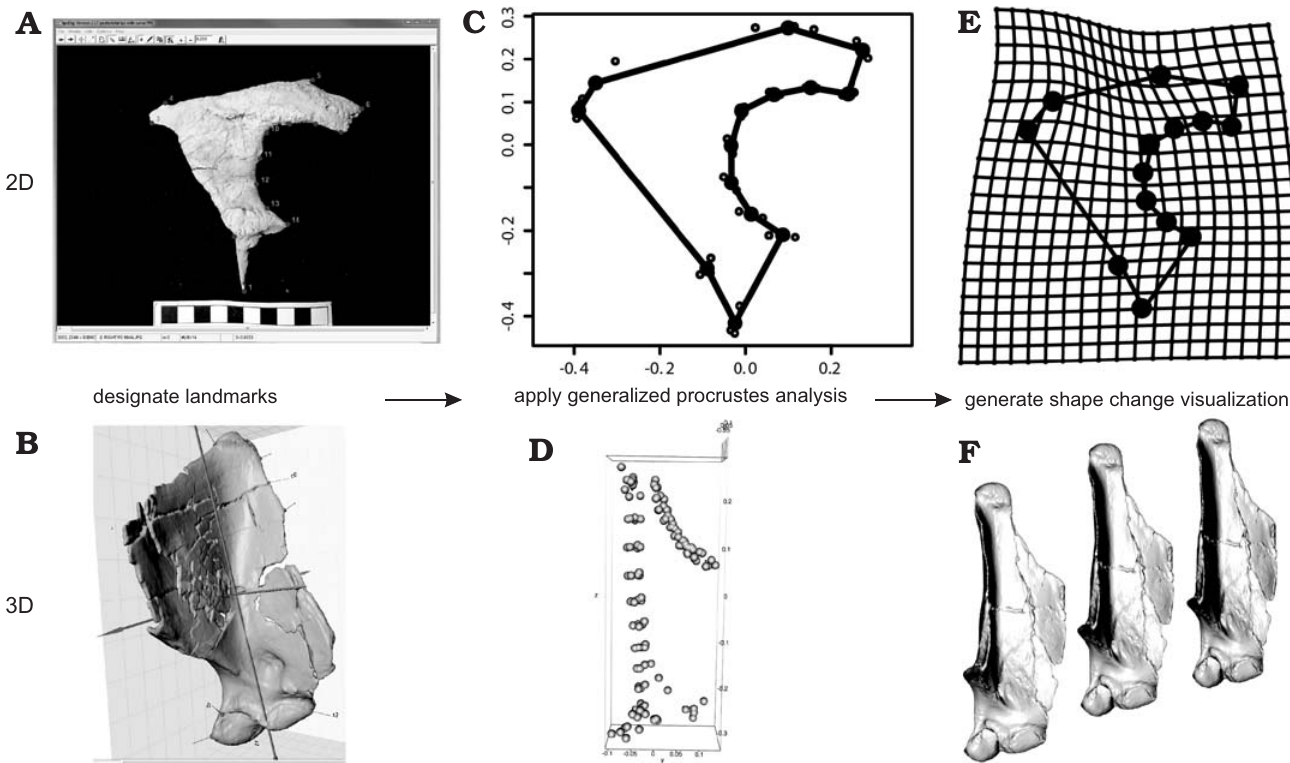
Fig. 2. Landmarks and semilandmarks designated using tpsDIG for 2D data ( A ) and landmark for 3D data ( B ). Landmark configurations aligned using generalized procrustes analysis, removing the effects of size, orientation, and position ( C , D ). Ontogenetic shape change visualized by generating defor- mation grids for 2D data ( E ) and warped meshes for 3D data ( F